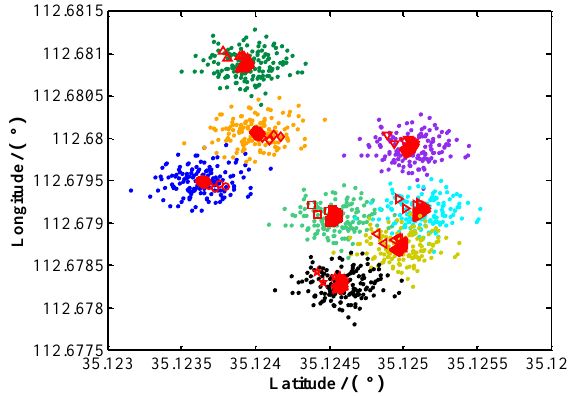
Figure 13. Localization results before and after RLS filtering.